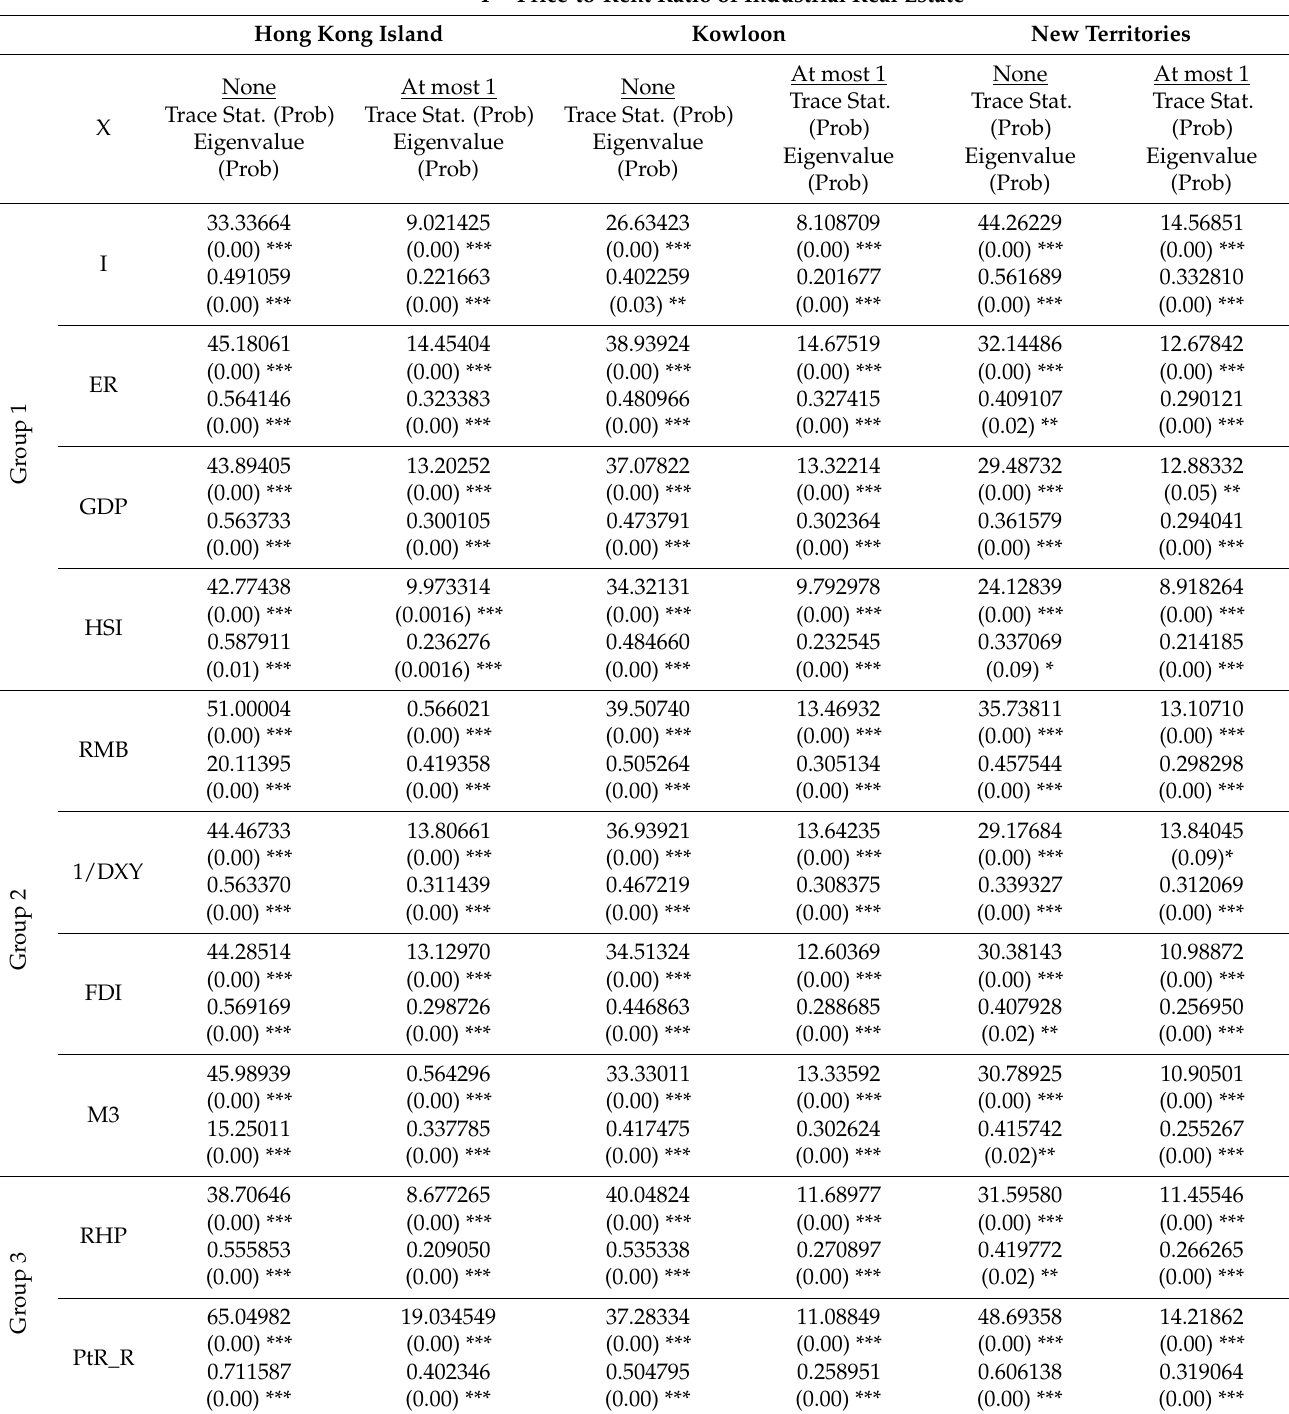
Table 3. Results of cointegration